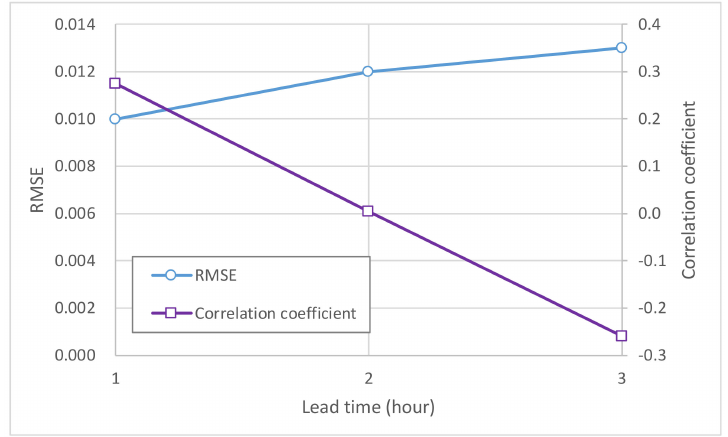
Figure 15. Summary of the performance indices of the inundation-depth estimates and comparison with the validation datasets at various lead times.